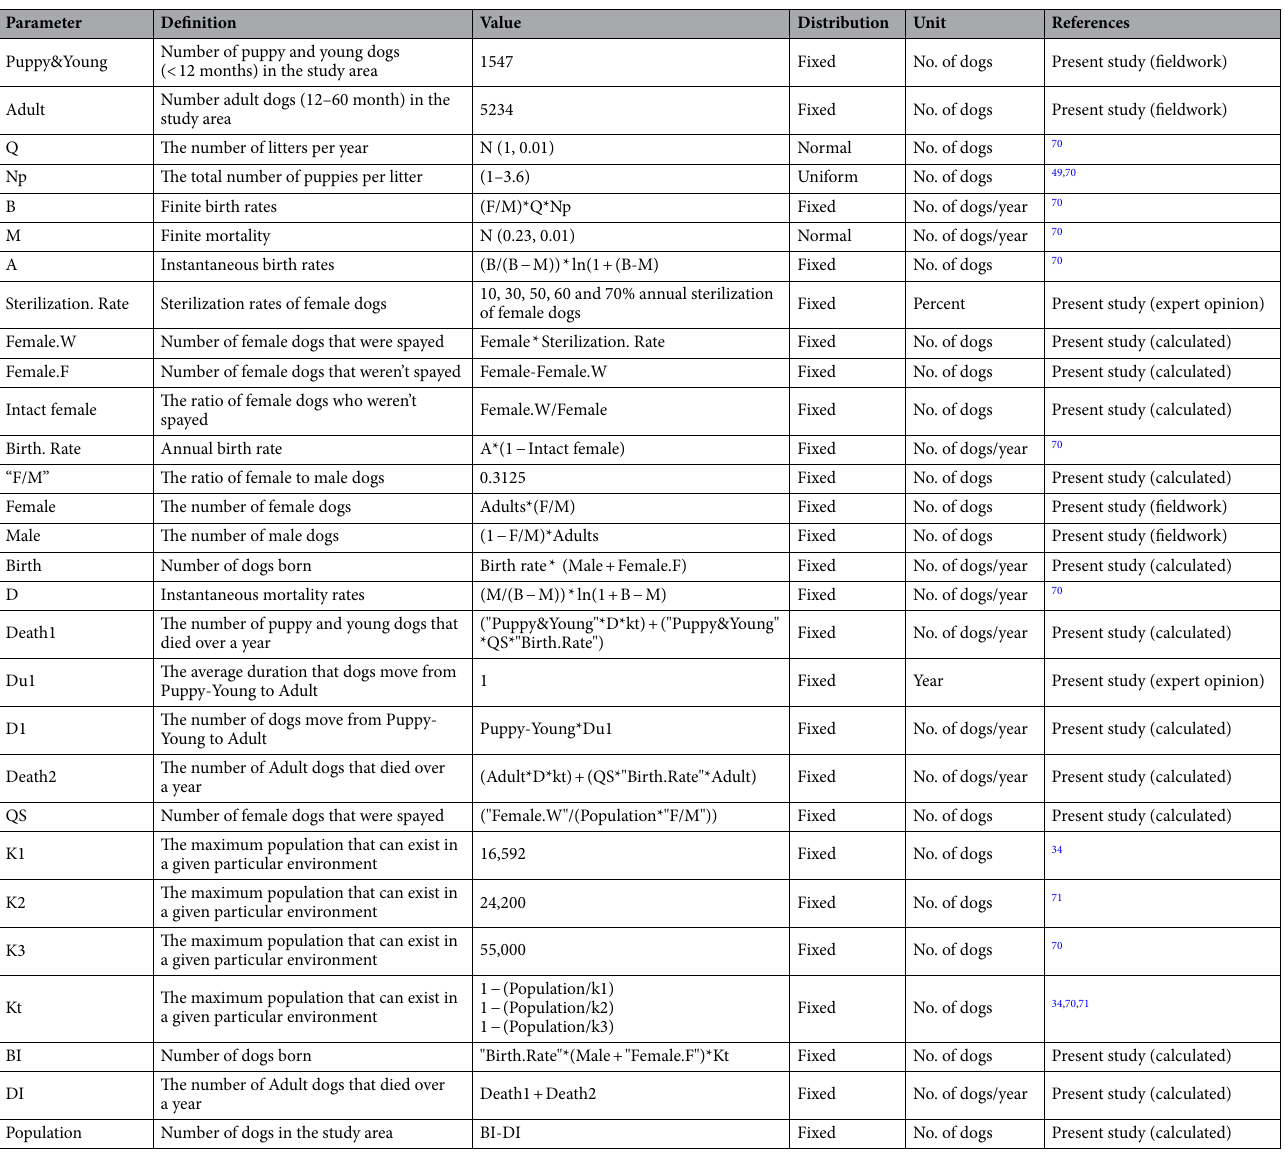
Table 4. Definition of the parameters and the values used in dynamic modeling of free-roaming dog population in Kerman and